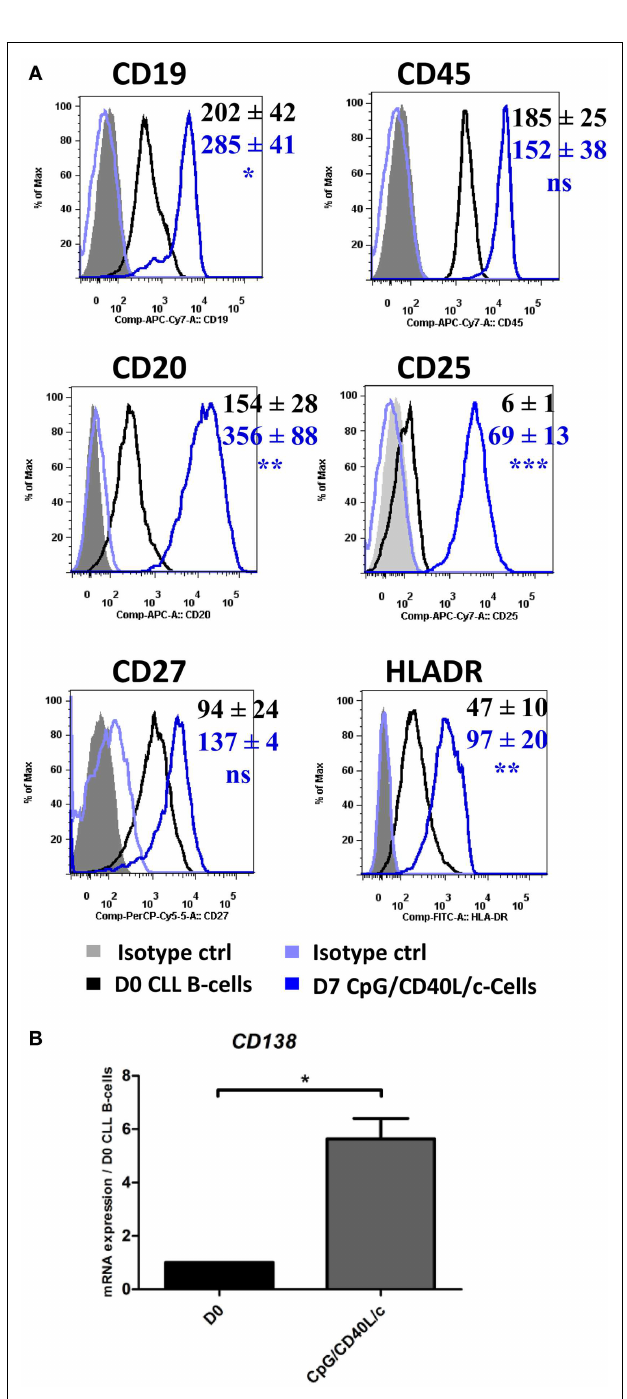
FIGURE 2 |The immunophenotype of the generated cells on D7 . On D0 and D7, the cell immunophenotype was studied by direct labeling of CD19, CD20, CD27, CD45, CD25, and HLADR. (A) Relative fluorescence intensities (RFIs) were calculated as the ratio between the mean fluorescence intensity (MFI) of cells labeled with a specific antibody and the MFI of cells labeled with a matched isotype control. Mean ± SEM RFI values from nine experiments are represented with a color code: black: D0 values, blue: D7 CpG/CD40L/-stimulated cells. Cytometry data are presented as plots from a representative patient. (B) The expression of the